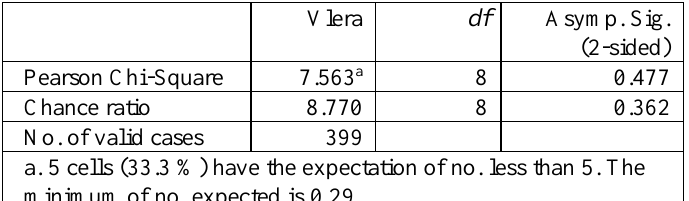
Table 4. Chi-SquareTest (developed by the